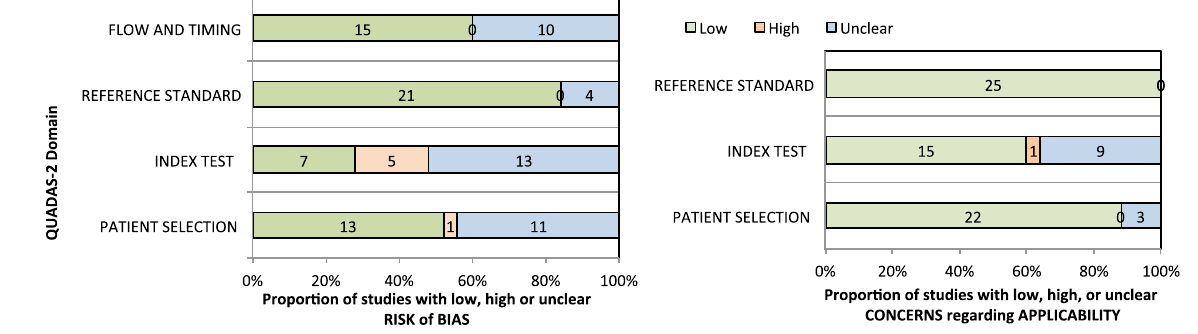
Figure 2. Results of QUADAS-2